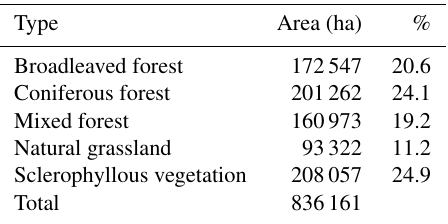
Table 3. Average and relative forested areas according to vegetation type between 1970 to